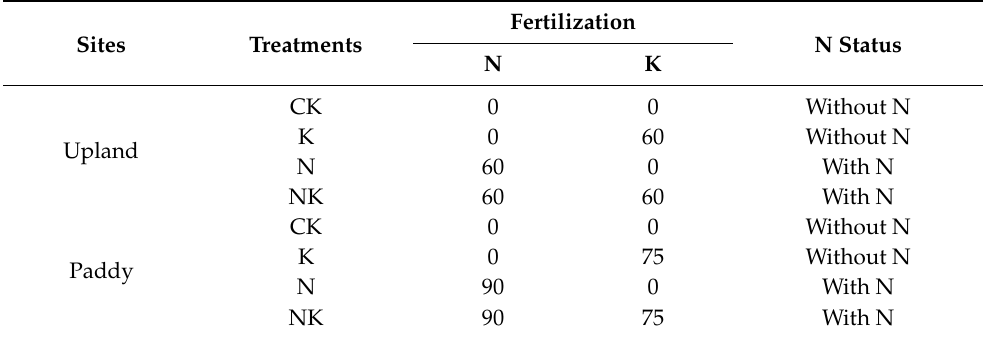
Table 1. The Annual rate (kg ha − 1 ) of synthetic nitrogen (N) and potassium (K) fertilizer addition and organic fertilizer applied in the various fertilization treatments. Sites Treatments